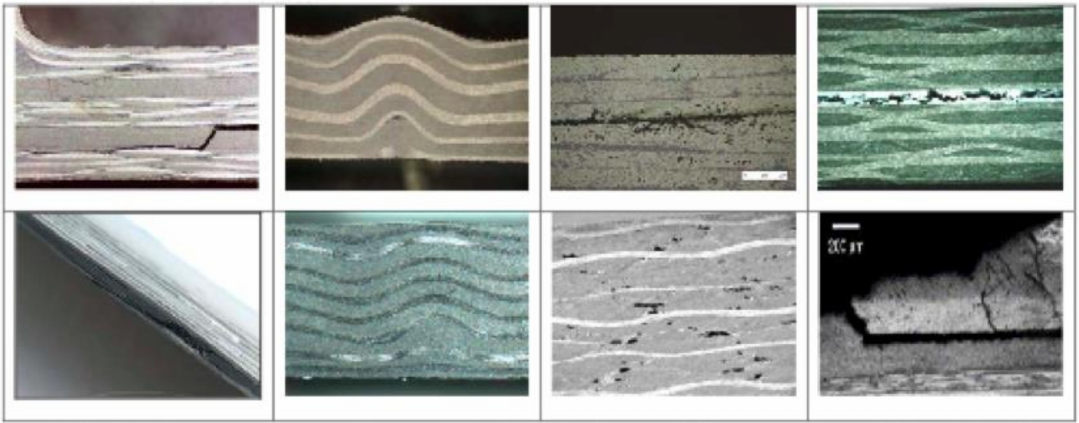
Figure 2. Typical defects / damages in composite laminates. From left to right, top to bottom: delamination with internal ply failures, external wrinkle, foreign object, internal and edge delaminations, internal wrinkle, distributed porosity, and